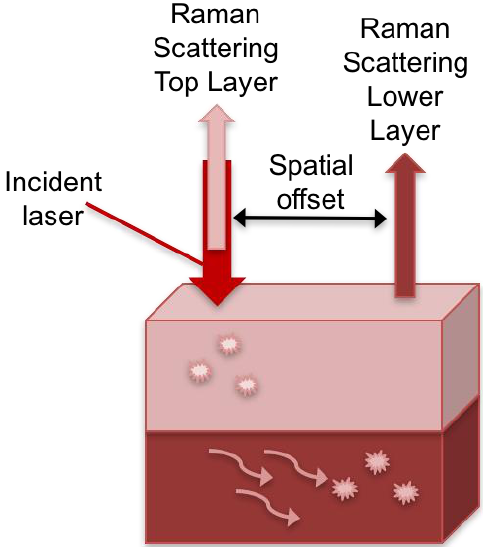
Figure 1. Schematic of spatially offset Raman spectroscopy (SORS) technique. The Raman scattered light collected along the same path as the point of incident illumination is due to the contributions from the surface layer. The Raman scattered light collected at a point spatially offset from the incident illumination point, allows for collection of the signal from subsurface layers where the photons that are deeper in the material migrate laterally before scattering from the surface.